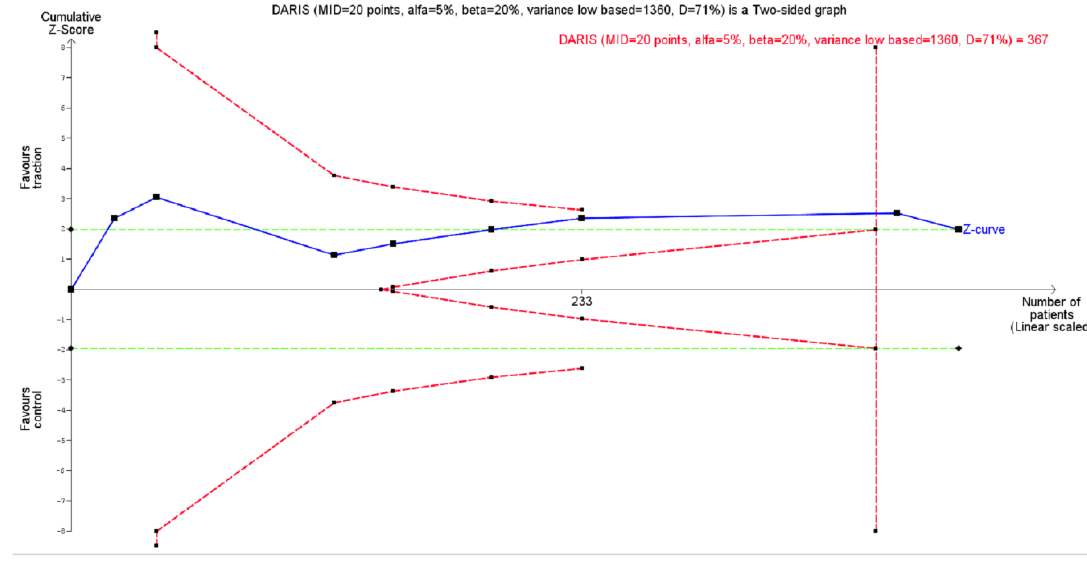
Figure 5. Trial Sequential Analysis (TSA) for pain in traction versus the control in cervical radicular syndrome. Diversity adjusted required information size (DARIS) of 367 patients was calculated using α = 0.05 (two sided), β = 0.20 (power 80%), diversity (D 2 ) = 71%, with a minimal important difference (MID) of 20 points out of 100 mm. The blue cumulative z curve was constructed using a random effects model. Solid squares denote individual trials; trials are plotted in chronological order (from left to right). The x -axis indicates the cumulative number of patients; the starting point of the z -curve is at x = 0 (i.e., inclusion of no trials). The dotted red lines indicate the monitoring boundaries for superiority, inferiority or futility, while the dotted green lines indicate the boundaries for a conventional statistic (i.e., 0.05).